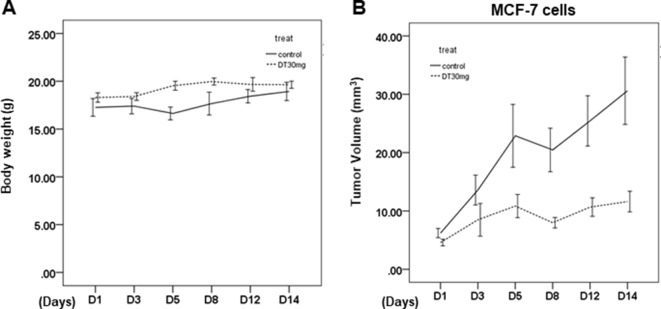
The in vivo effect of dihydroisotanshinone I (DT) on xenografted animal model. (A) Average mice weights with every 2-day injection of vehicle/DT over a time course of 2 weeks. (B) Average tumor volume of mice injected with either vehicle (DMSO) or DT (30 mg/kg, n = 5 per group). (Error bars = mean ± S.E.M.).